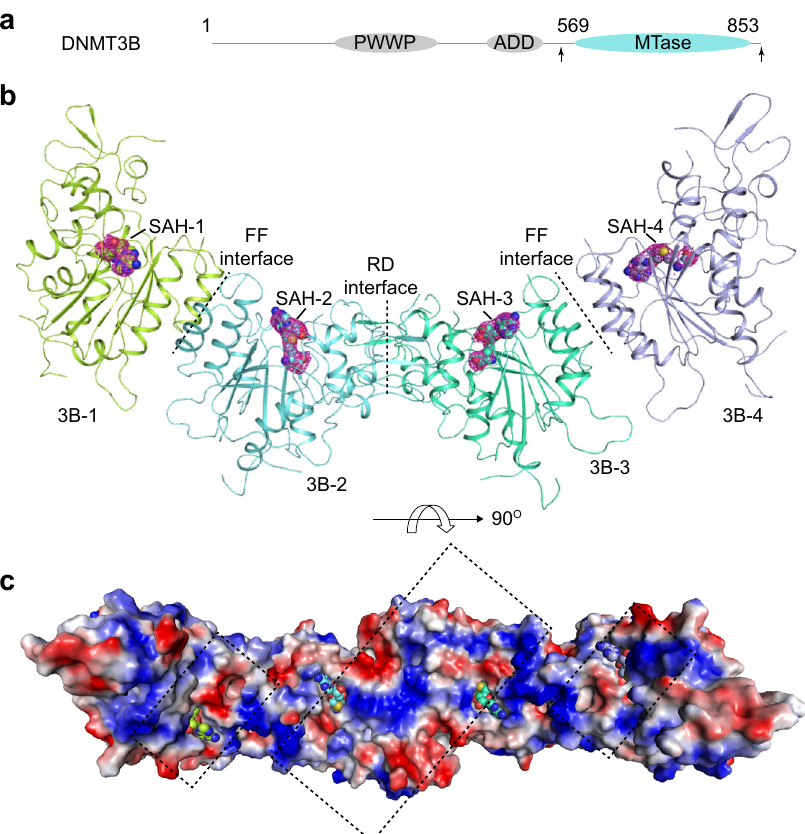
Fig. 1 Crystal structure of the homo-oligomeric DNMT3B MTase domains. a Color-coded domain architecture of DNMT3B, with the MTase domain used for structural study delimited by arrows. Ribbon diagram ( b ) and electrostatic surface ( c ) of the tetrameric unit of DNMT3B homo-oligomer, with the DNMT3B-bound SAH molecules shown in sphere representation. The individual DNMT3B molecules are labeled as 3B-1, 3B-2, 3B-3, and 3B-4, respectively. The potential DNA-binding surface of the RD interface-mediated DNMT3B dimer is indicated by a rectangle. In the electrostatic surface, red, blue and grey colors indicate negative, positive and neutral potential, (Fig. 2b – d). In the DNMT3B-DNMT3L complexes, DNMT3B